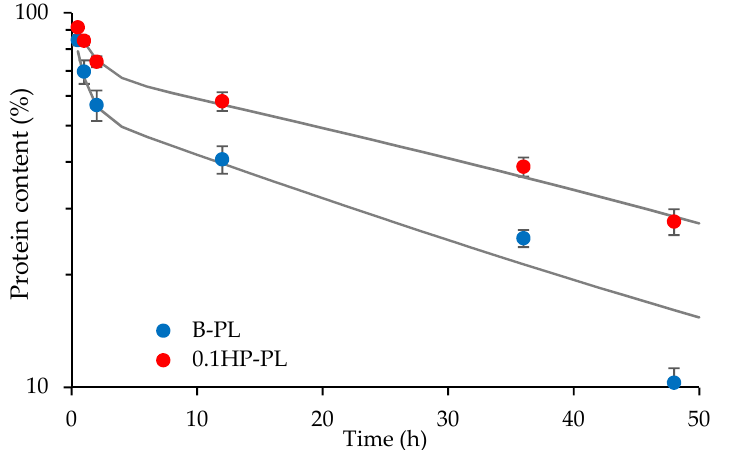
Figure 9. Profile of protein release from tubular aligned scaffolds in the trans-well system configuration. Platelet lysate (PL) diluted 1:20 in HBSS was placed in the lower chamber. B (blue dots) and 0.1 HP (red dots) scaffolds were placed over the insert in the upper chamber, see text (mean values ± s.d.; n = 4). The fitting curves are drawn in grey.